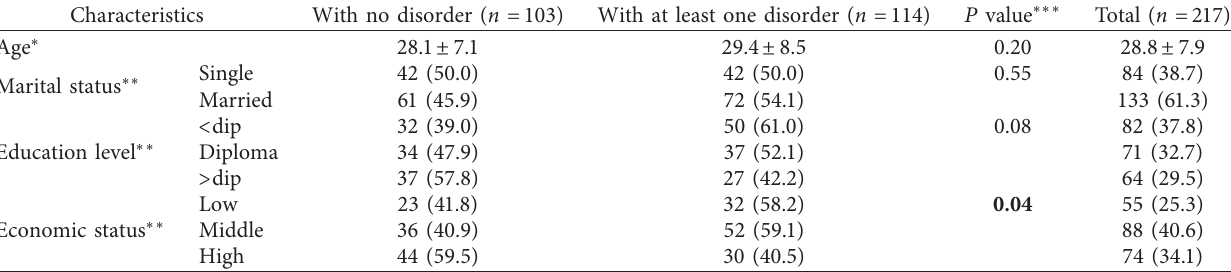
Table 1: Demographic characteristics of participants with or without menstrual disorders.